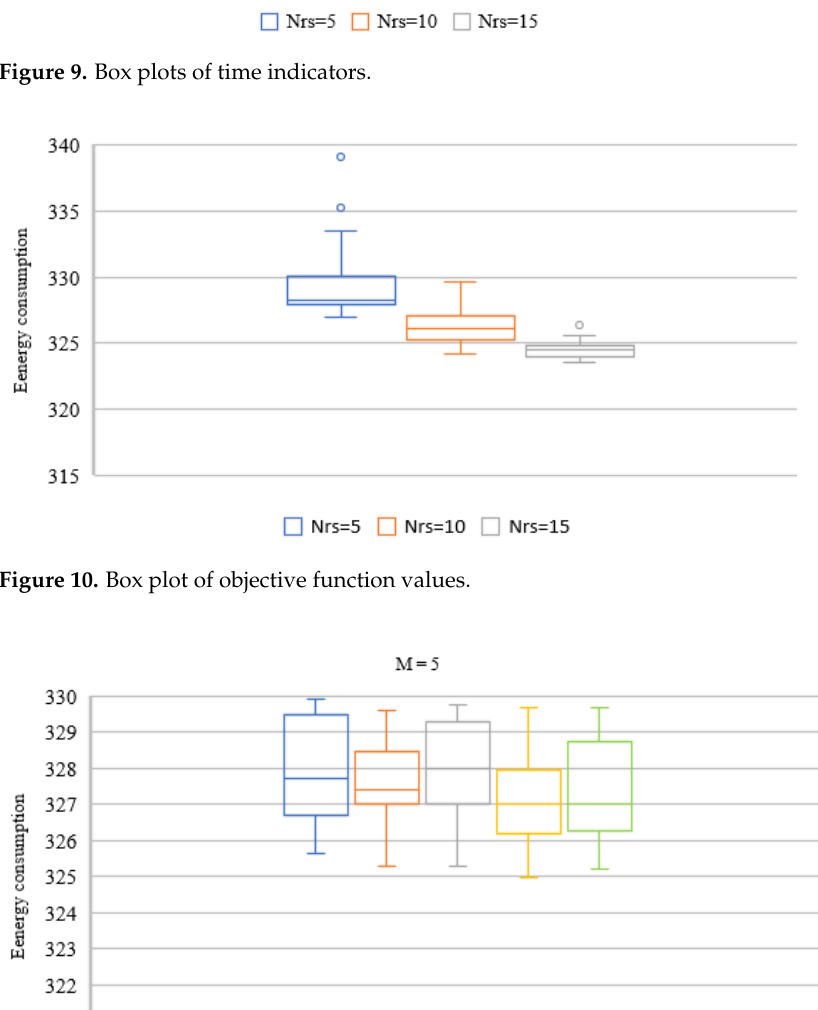
Figure 11. Box plot of the objective function at an initial population of